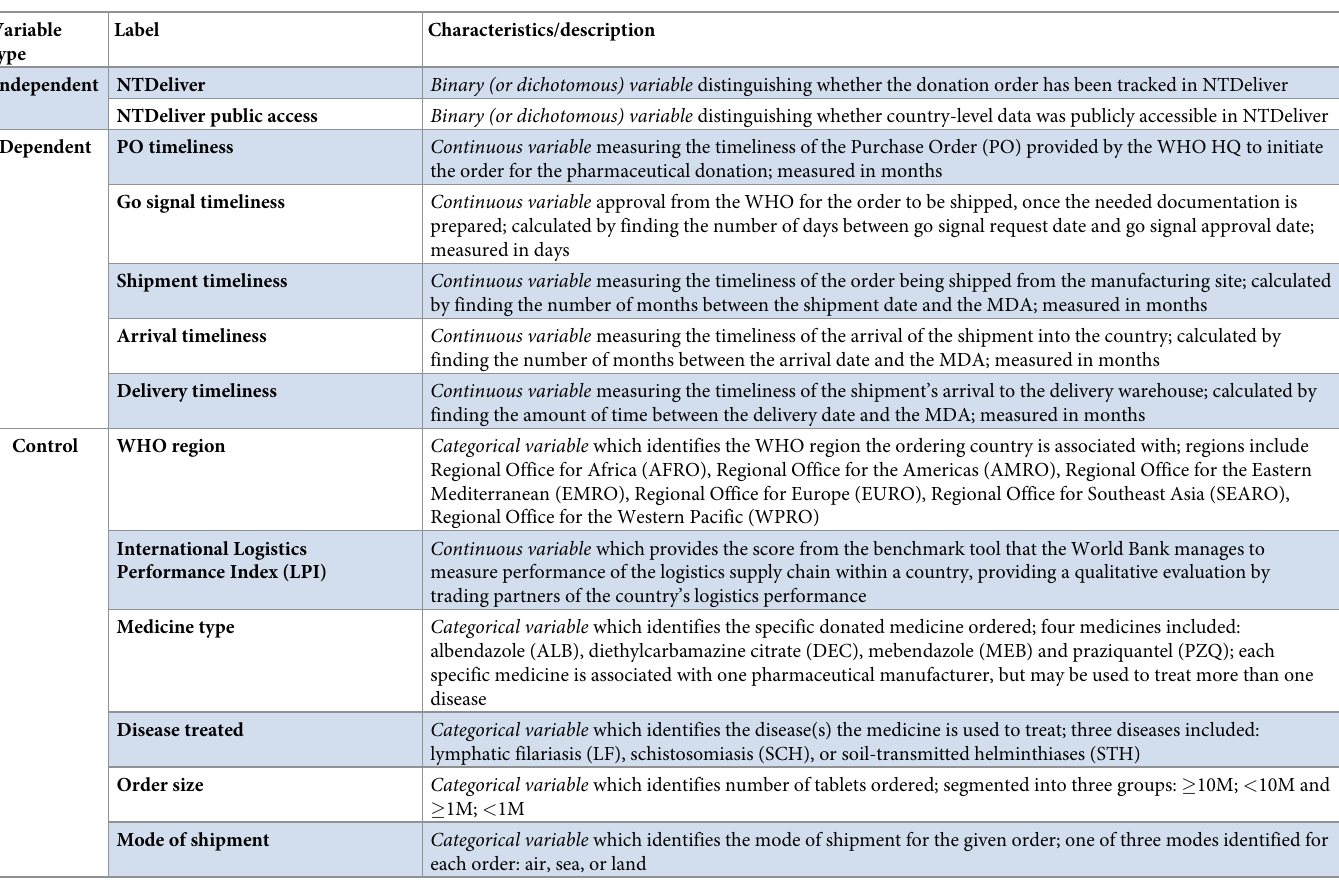
Table 1. Variable definitions. Variable Label type